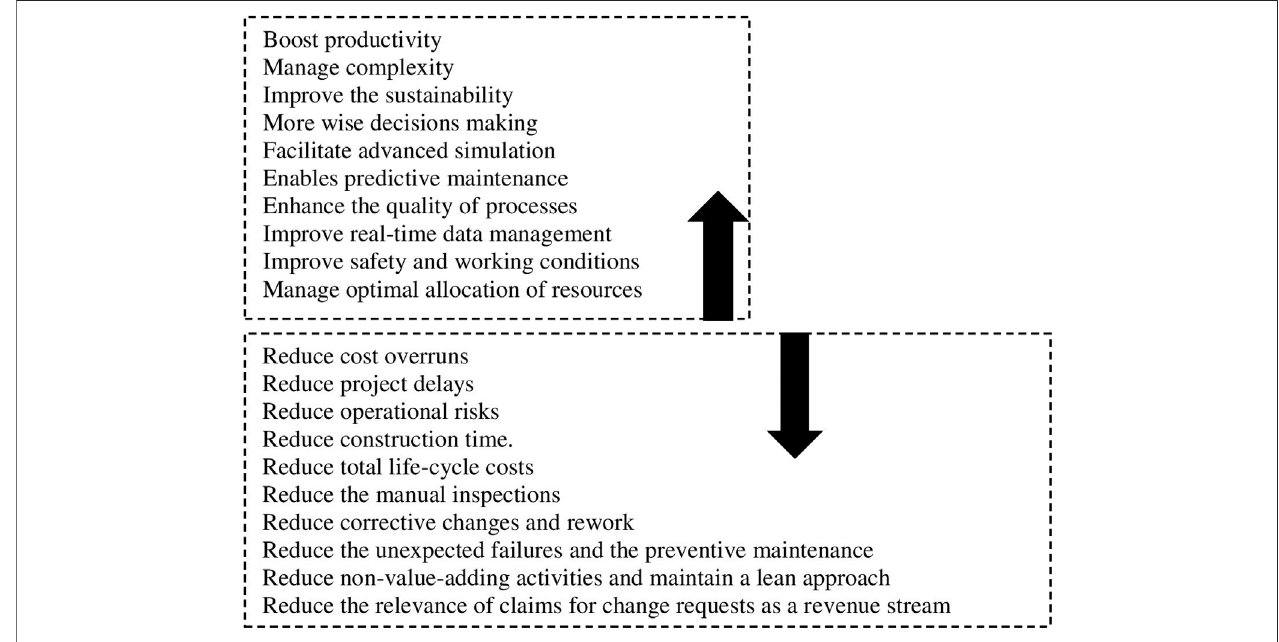
FIGURE 6 | Digital technology adoption bene fi ts in the AEC industry.